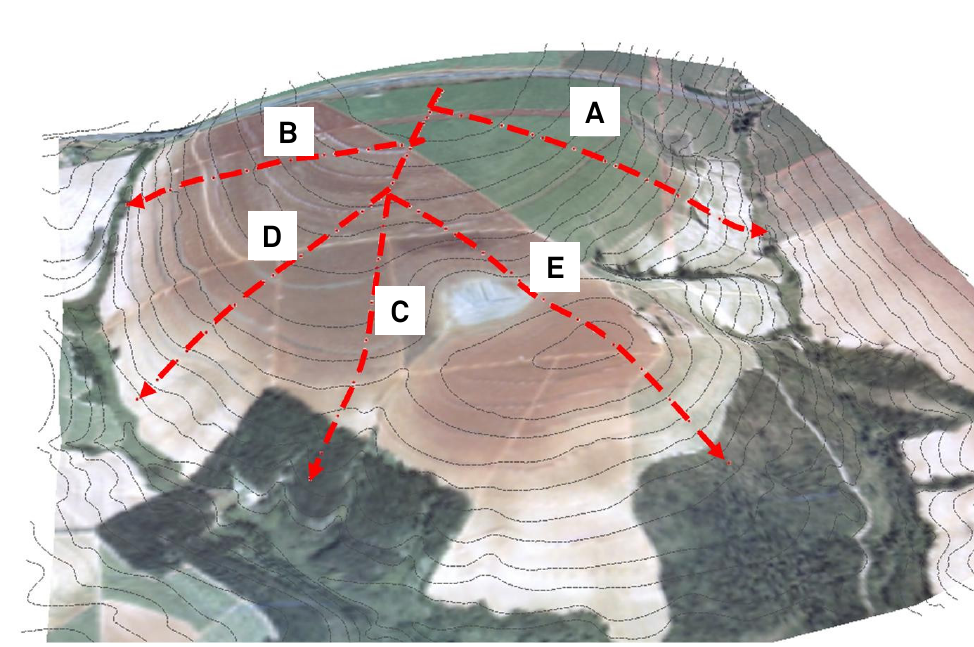
Figura 1. localização das topossequências a, B, C, d e E na área de